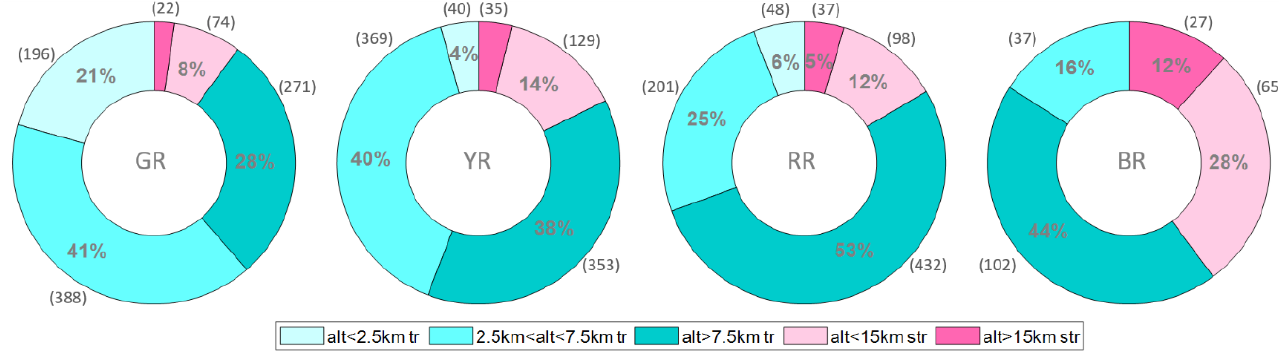
values, while the min. and max. values are indicated at the end of the whiskers. The box limits correspond to the 75th and 25th percentile values of the